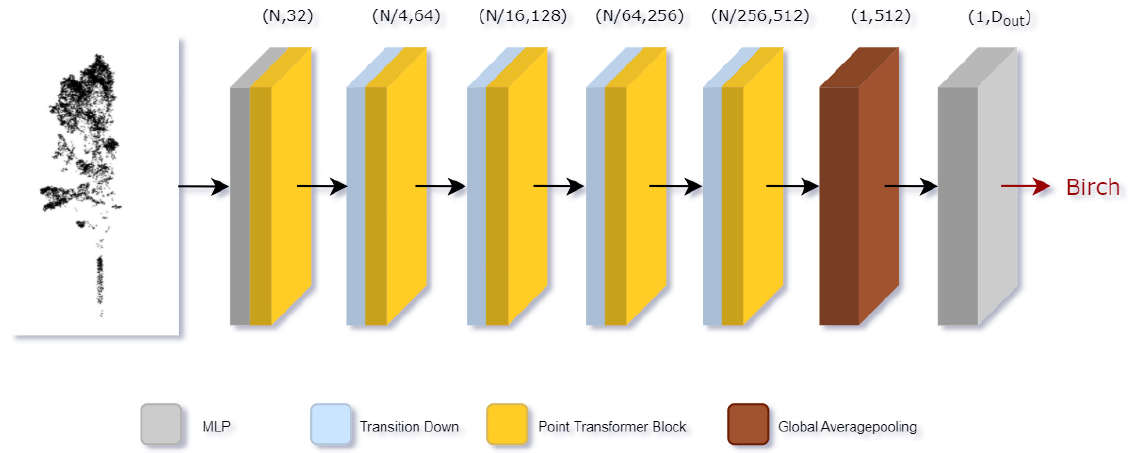
Figure 8. The architecture (PT1) proposed by Zhao [29], including mlp, point transformer block, transition down block, and global average pooling, where N refers to input point numbers. The transition down module is to reduce the cardinality; the point transformer is the core module to output features.